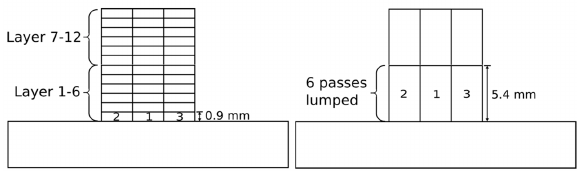
Figure 7. Sketch showing how the passes can be lumped.